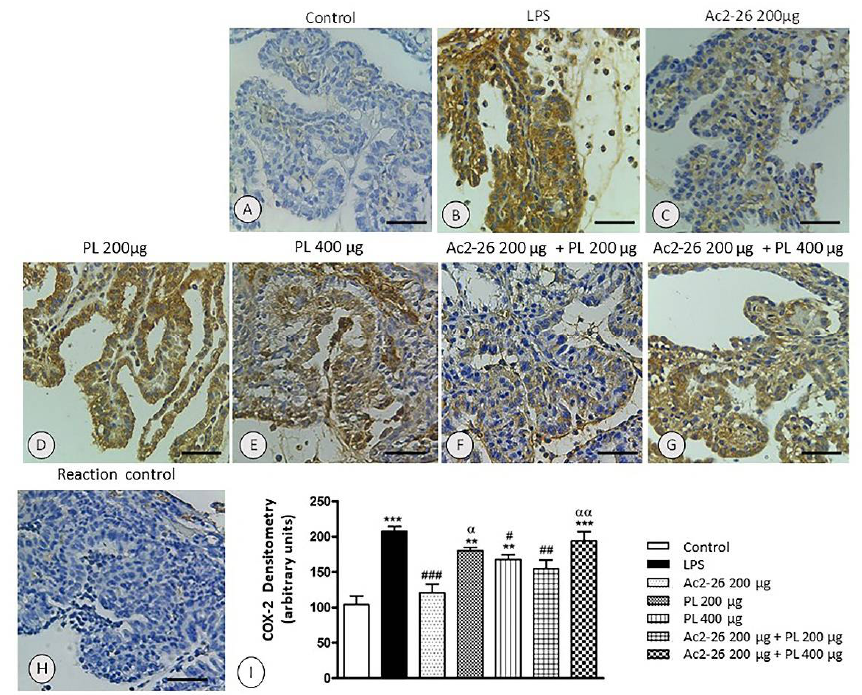
Figure 5. Expression of the COX-2 enzyme in ciliary processes in EIU. Absence of immunostaining in the control eyes ( A ). Strong immunostaining in the untreated, induced EIU animals (LPS) ( B ) and those treated with PL 200 µg ( D ) and Ac2-26 + PL 400 µg ( G ). Decreased expression after systemic treatments with Ac2-26 ( C ), PL 400 µg ( E ), and Ac2-26 + PL 200 µg ( F ). Absence of immunostaining in the control eyes ( H ). Counterstaining: hematoxylin, bars: 10 µm. Densitometric analysis of COX-2 ( I ). Results were obtained as mean ± SEM of the densitometric index of the eyes of control rats, untreated uveitis (LPS), and treated groups (Ac2-26 200 µg, PL 200 µg, PL 400 µg, Ac2-26 + PL 200 µg, and Ac2-26 + PL 400 µg) ( n = 10 animals/group). *** p < 0.001 and ** p < 0.01 versus control; # p < 0.05, ## p < 0.01, and ### p < 0.001 versus LPS; αα p < 0.01 and α p < 0.05 versus Ac2-26 200 µg .